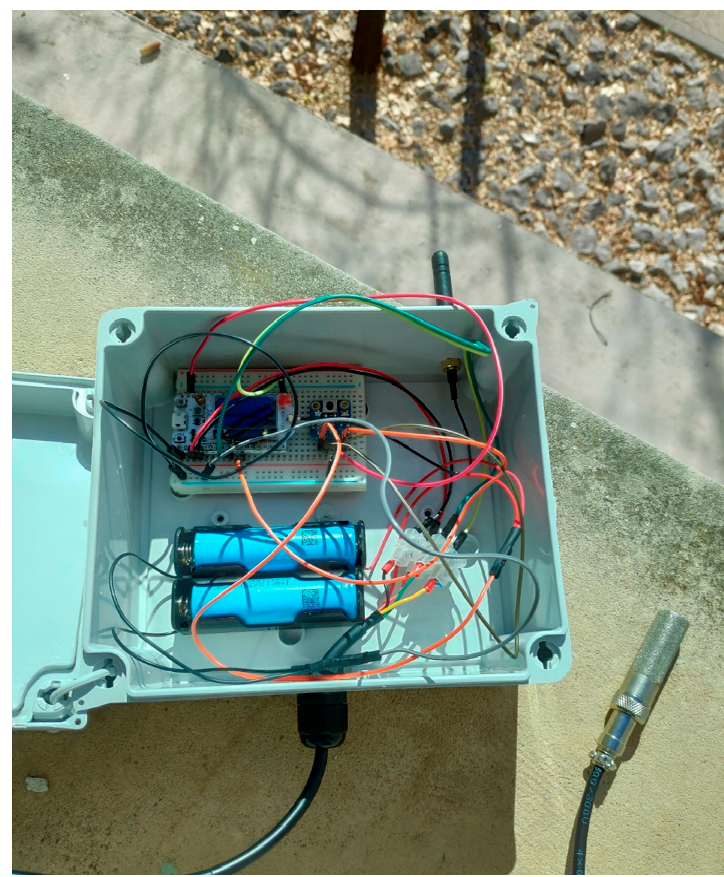
Figure 17. Monitor Node. Sensors 2019 , 19 , x FOR PEER REVIEW